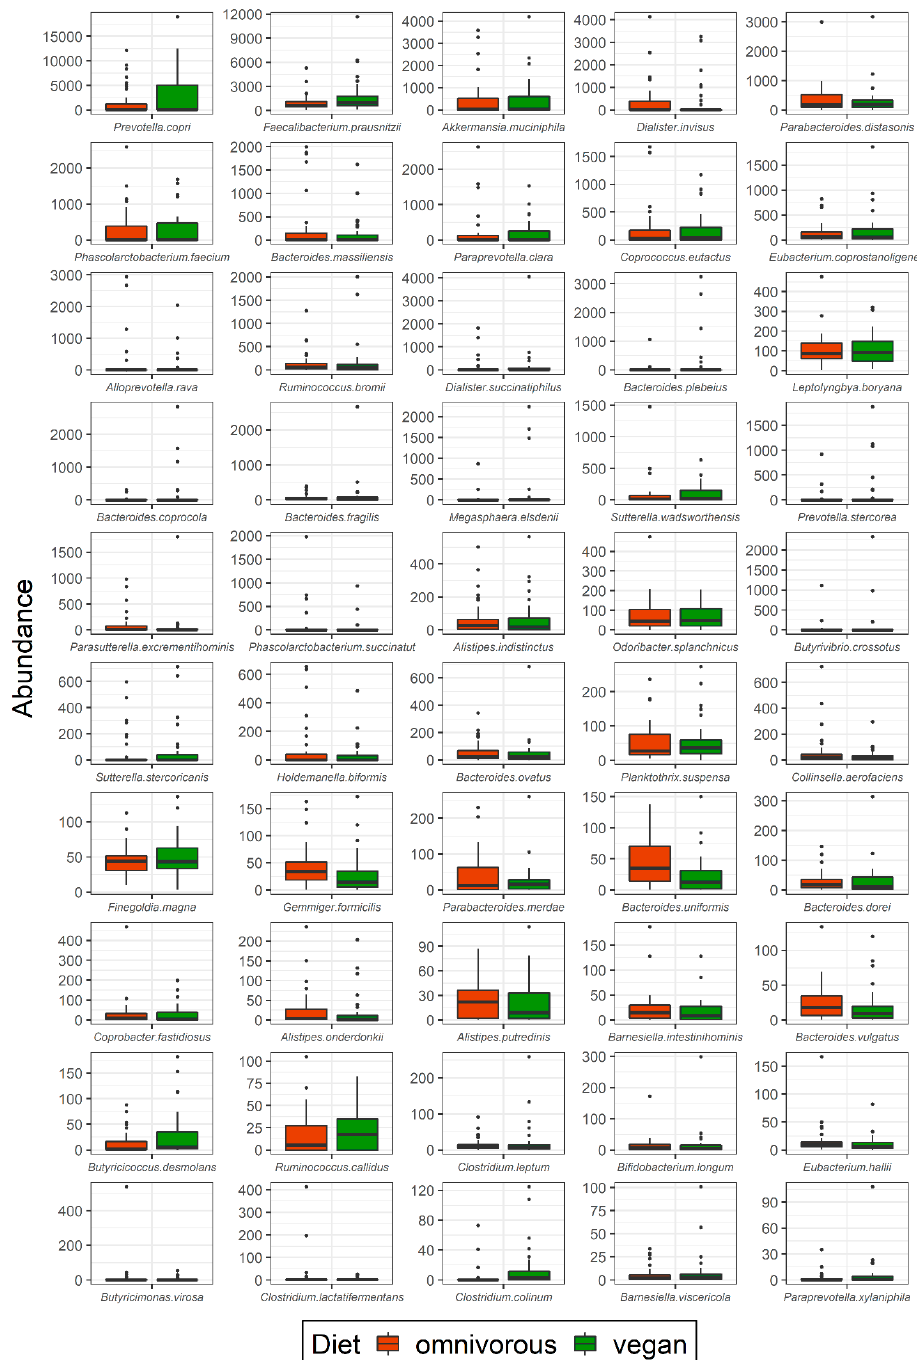
Figure 4. Gut microbiota composition at species level in vegans and omnivores. Abundances of bacteria at species level in vegans and omnivores are presented as number of reads using 16S rRNA sequencing. Significant differences were observed for Butyricicoccus desmolans ( p = 0.049) , Clostridium colinum ( p = 0.004) , Dialister succinatiphilus ( p = 0.02), Bacteroides uniformis ( p = 0.004), Bacteroides vulgatus ( p = 0.07) , Parasutterella excrementihominis ( p = 0.04), and Dialister invisus ( p =